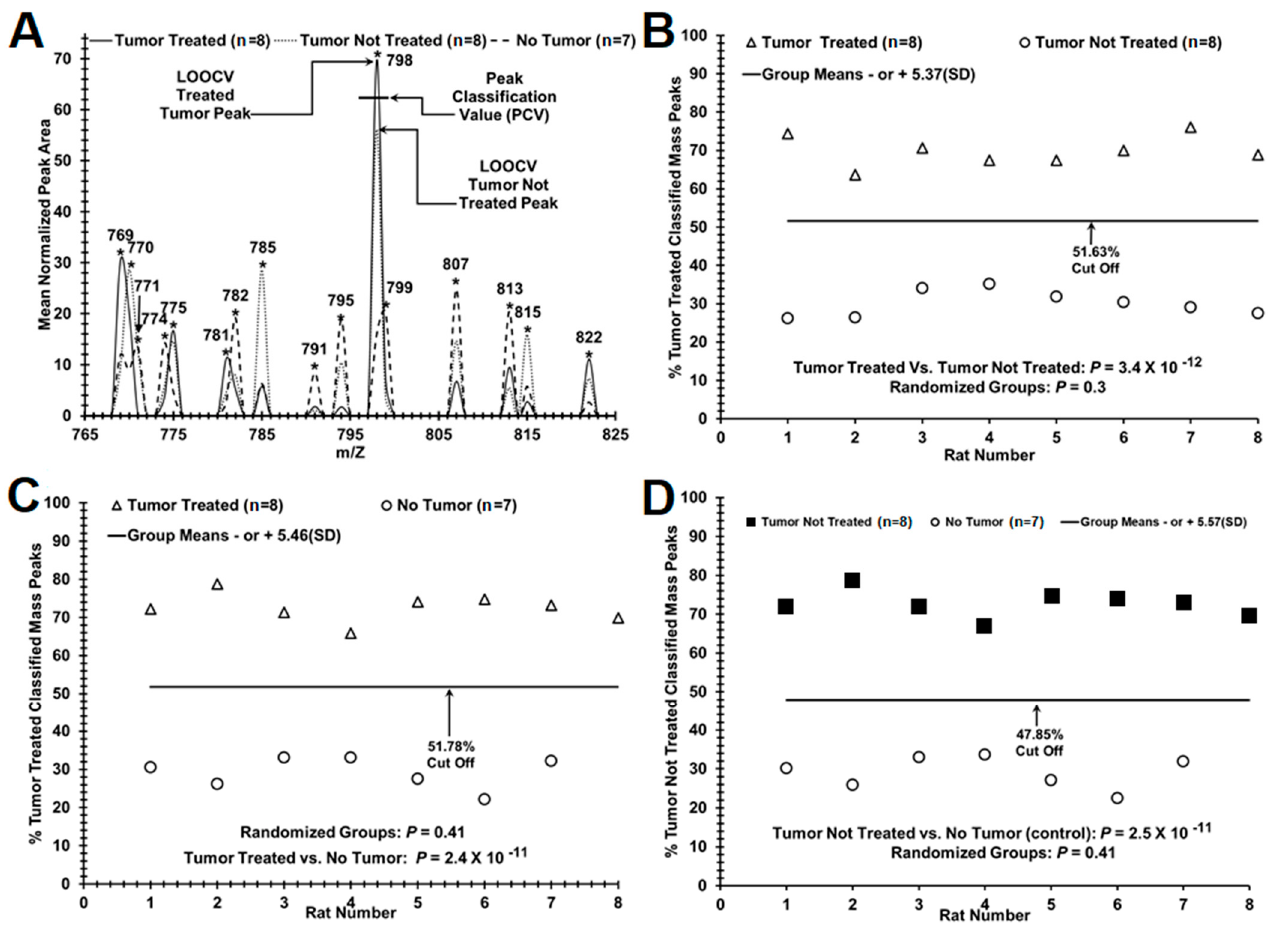
Figure 1. Distinguishing control rodents from treated and untreated brain tumors from each other and from controls using ESI-MS serum mass profiling. ESI-MS (electrospray ionization mass spectrometry) and other procedures were performed as described in the Methods. Panel ( A ) depicts electrospray MS methodology was used to identify, quantify, and classify significant sera m/z peaks signal into tumor treated (solid line) or tumor not treated (dotted line) peak area descriptors determined by mass peak areas are averages from 8 individual serum samples per category. No tumor controls (dashed line). Panel ( B ) shows a difference in distribution between sera from tumor treated rodents ( Δ , open triangles) versus sera of untreated rodents ( ○ , open circles) based on significant “% of tumor treated classified mass peaks”, using the mass peak analyses described in the Materials and in panel A. Panel ( C ), mass peak distribution difference between sera from tumor treated animals ( Δ , triangles) and controls. Panel ( D ), mass peak distribution difference between sera from tumor non-treated animals ( ■ , closed squares), and no tumor controls ( ○ , open circles). p -values for each group separation are provided. “Cut-offs” are greater than five standard deviations (S.D.) below % mass peaks mean and are used for test metric analysis. * indicates the m/Z molecular mass peak for each major peak